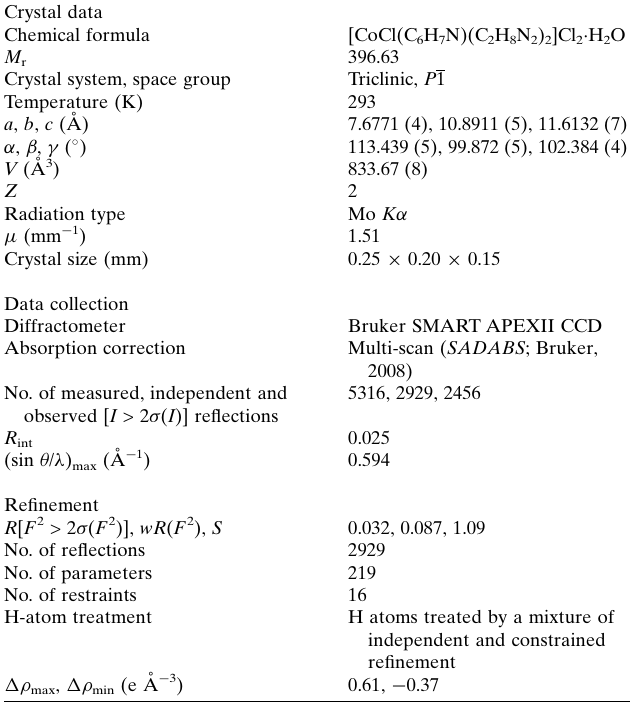
Table 2 Experimental details. Crystal data Chemical